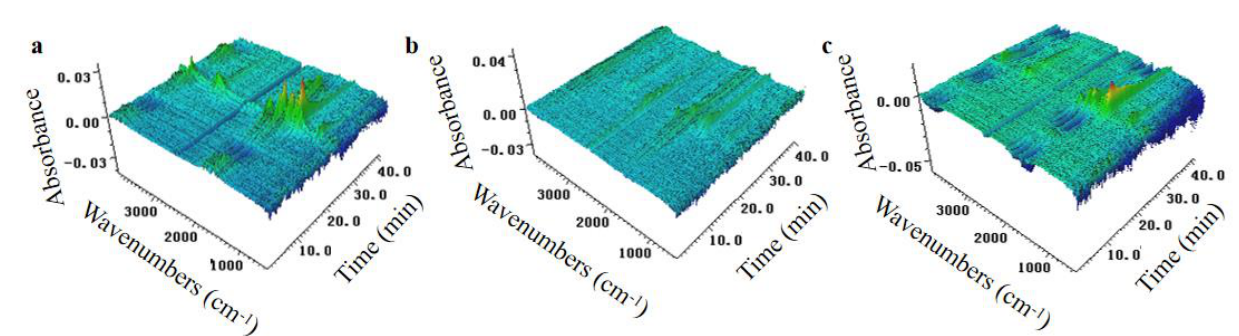
Figure 11. TG-IR spectra of thermal degradation products of EP/DDS ( a ), EP/DDS/HPCP/9 ( b ), and EP/DDS/HPCP-6/H-U-3 ( c ).